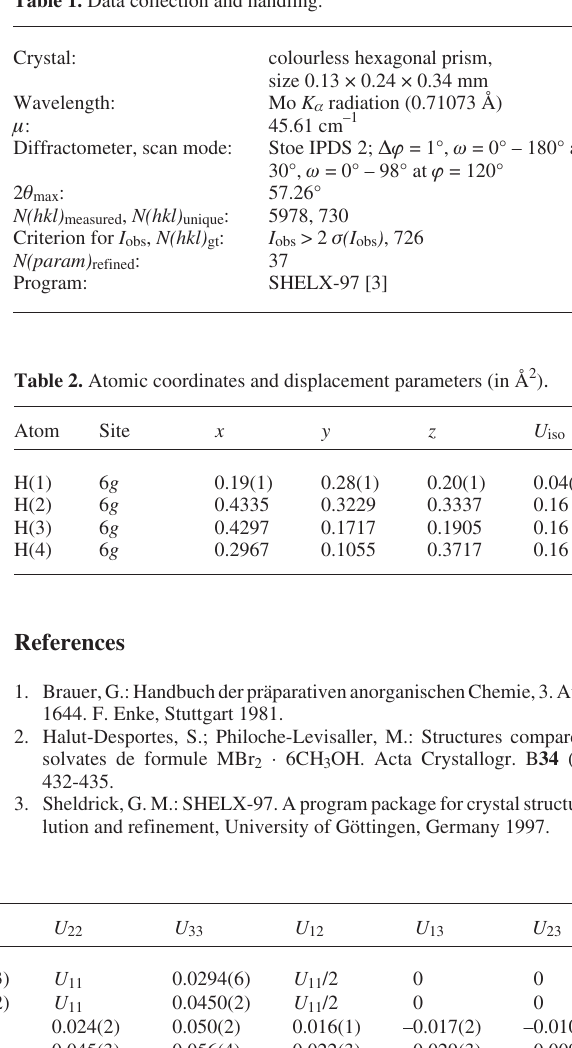
Table 1. Data collection and handling.